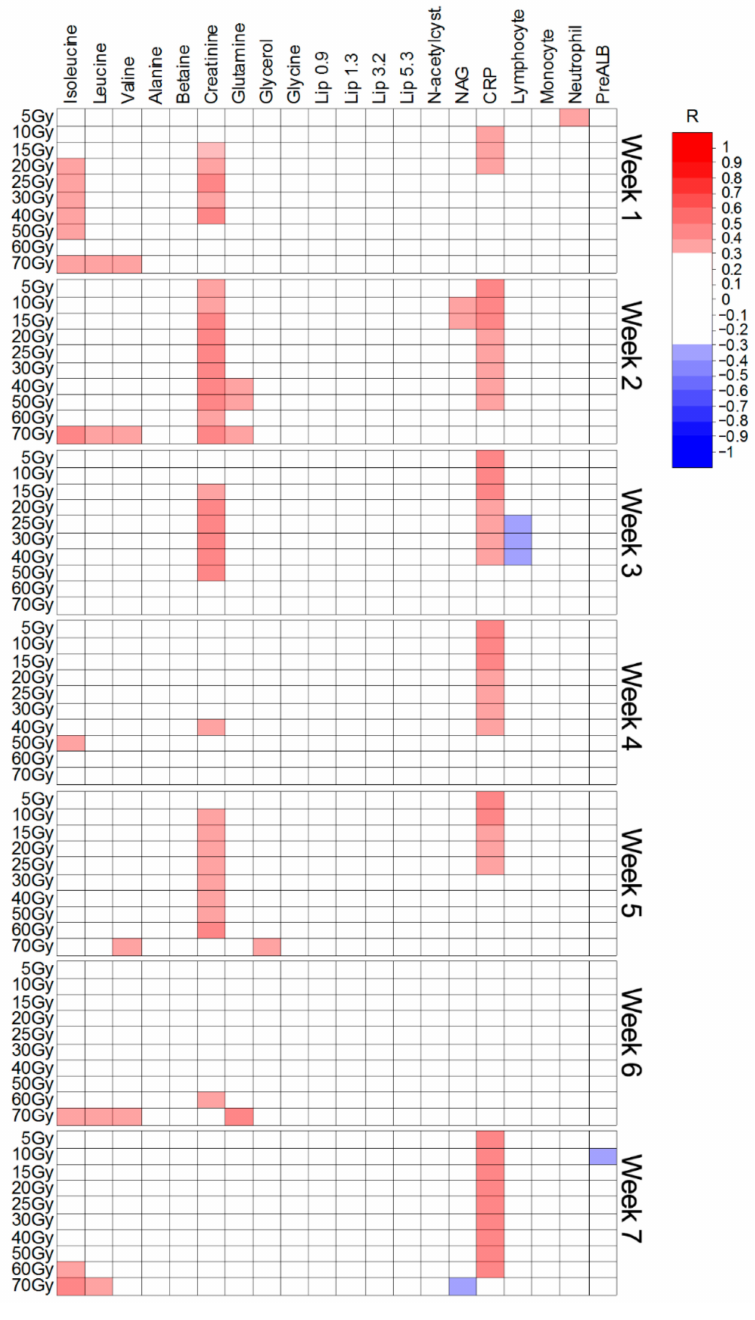
Figure 5. Heat map of the Spearman’s correlations between the blood serum metabolites and the irradiated volumes receiving a particular dose during concurrent